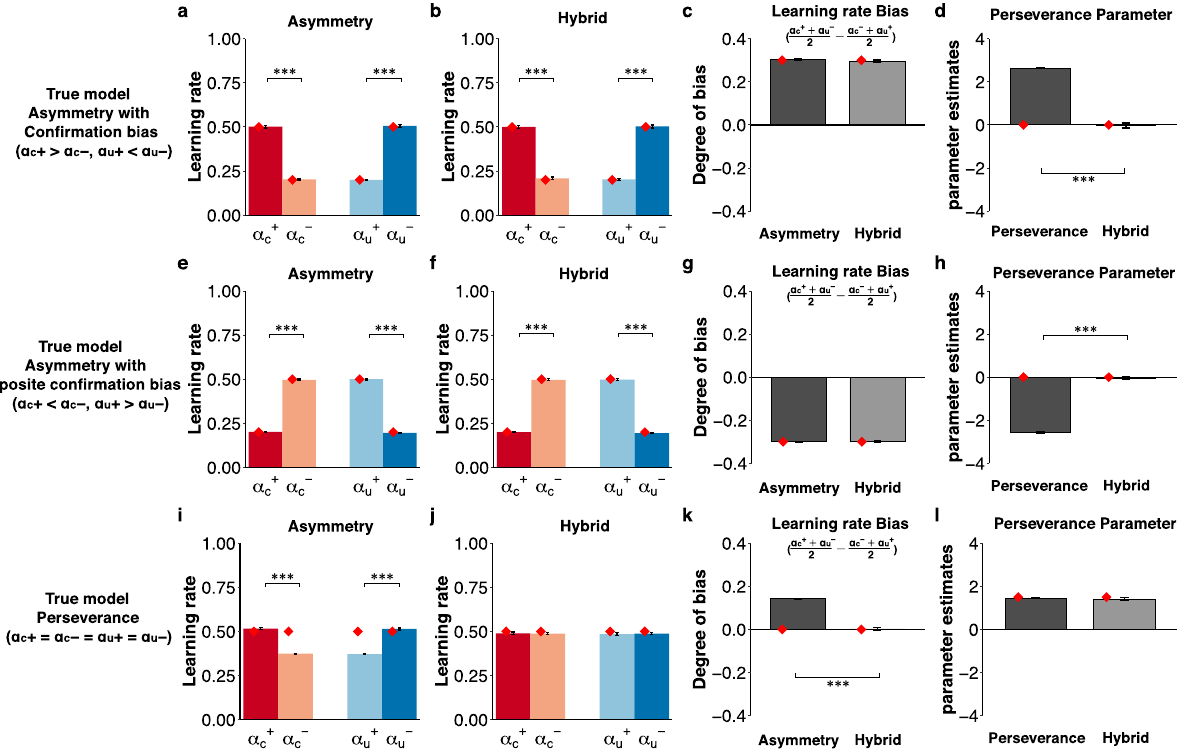
Figure 3. The results of the simulation in the counterfactual learning context. ( a – d ) The results of the true model with asymmetric learning rates assuming confirmation bias ( α + c = 0.5, α − c = 0.2, α + u = 0.2, α − u = 0.5 ). ( e – h ) The results of the true model with asymmetric learning rates assuming opposite confirmation bias ( α + c = 0.2, α − c = 0.5, α + u = 0.5, α − u = 0.2 ). ( i – l ) The panel shows the results of the true model with symmetric learning rates ( α + c = α − c = α + u = α − u = 0.5 ) and choice perseverance ( φ = 1.5). ( a , e , i ) The first column indicates the learning rates ( α + c , α − c , α + u , α − u ) in the Asymmetry model. ( b , f , j ) The second column indicates the learning rates in the Hybrid (gradual) model. ( c , g , k ) The third column indicates the degree of confirmation bias α + c + α − u − α − c + α + u (cid:31) 2 2 (cid:30) . ( d , h , l ) The final column shows the perseverance parameter ( φ ) in the Perseverance (gradual) and Hybrid (gradual) models. *** p < 0.001, ** p < 0.01 and * p < 0.05. The error bars represent the standard error of the mean. The diamonds denote the ground-truth value of the parameters used in the data